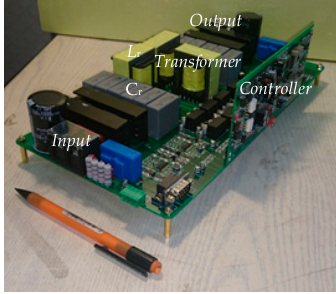
Figure 13. The prototype of the experimental setup.